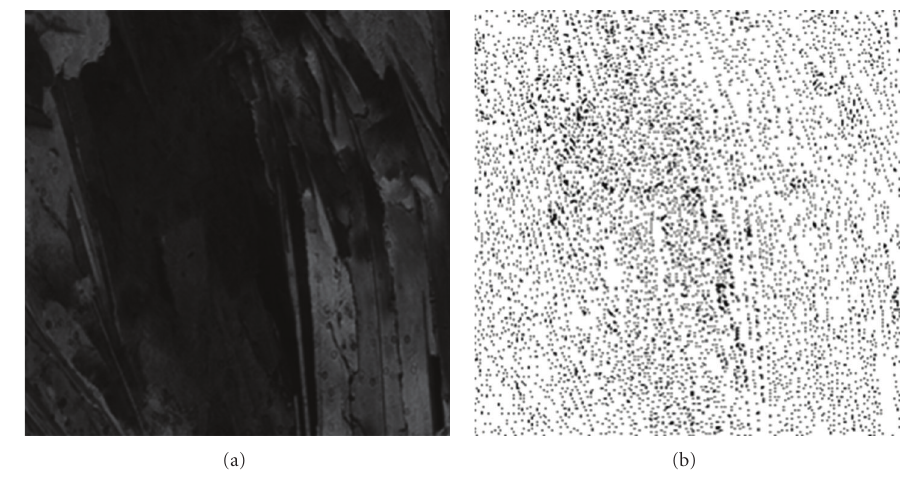
Figure 2: (a) Gray scale image. (b) The LBP